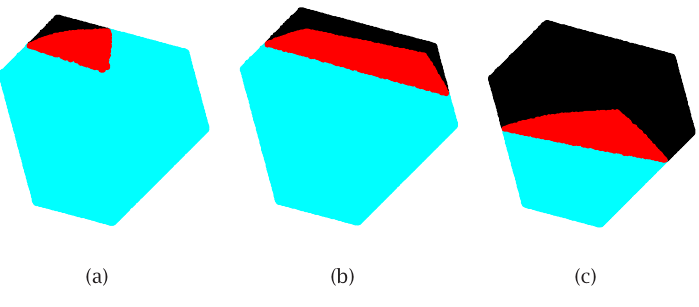
Figure 4.1 . The partition of the Horn-Schur polytope for d = [ 0 , 3 / 4 , 2 ] (cid:4)